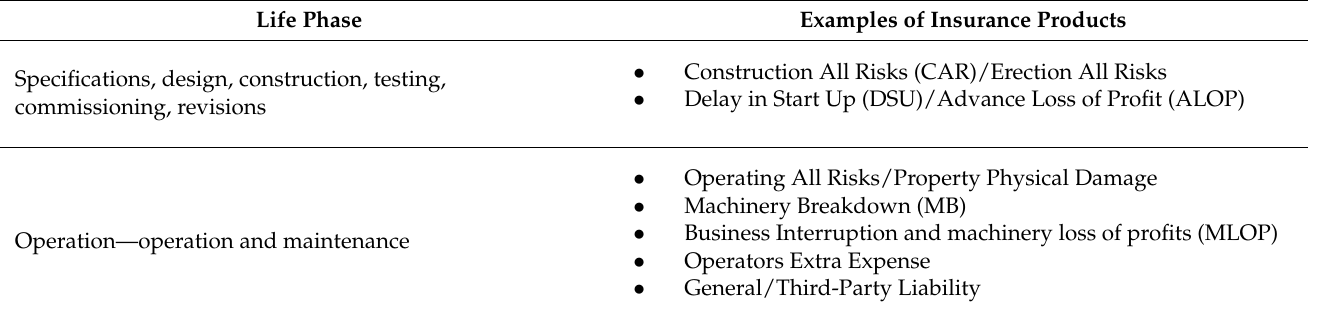
Table 2. Examples of insurance products offered at different stages of life. Life